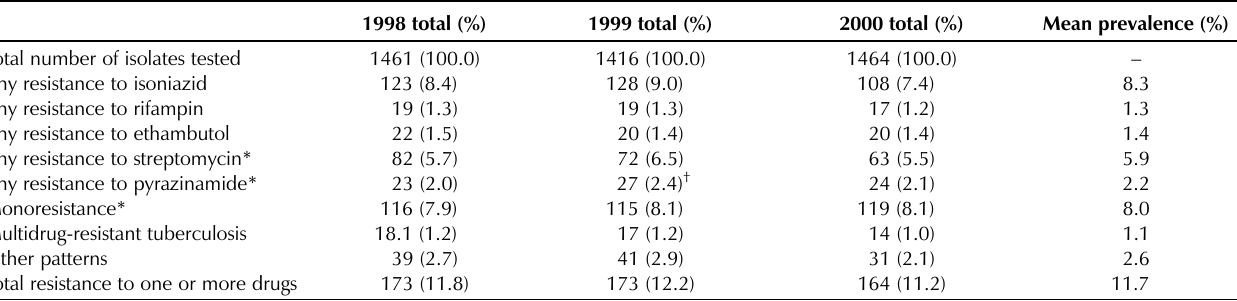
Overall pattern of reported tuberculosis drug resistance in Canada, 1998 to 2000